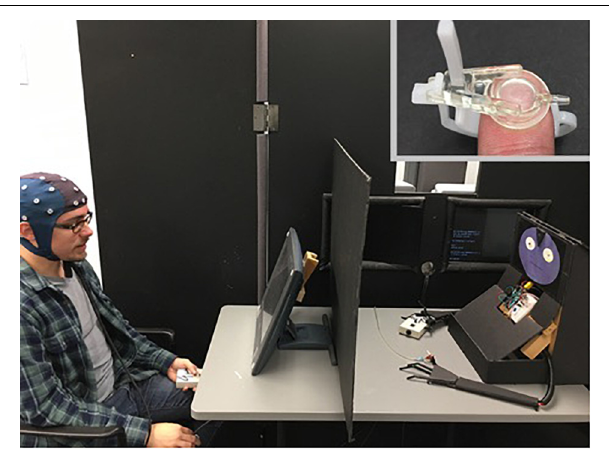
FIGURE 1 | Experimental setup during the robot condition. Participants responded to visual stimuli presented on the monitor. The robot used for this study is on the right side of the barrier. The embedded image in the top right shows how the stimulation device is attached to the index finger of the participant. Written informed consent was obtained from the individual on the left for publication of this